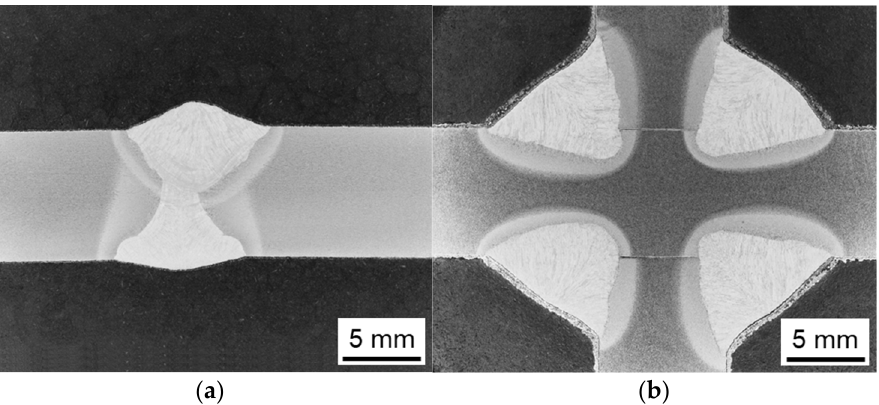
Figure 5. Macro-sections of thermally sprayed specimens, etched with Nital (5%), ( a ) butt-weld; ( b ) fillet weld.